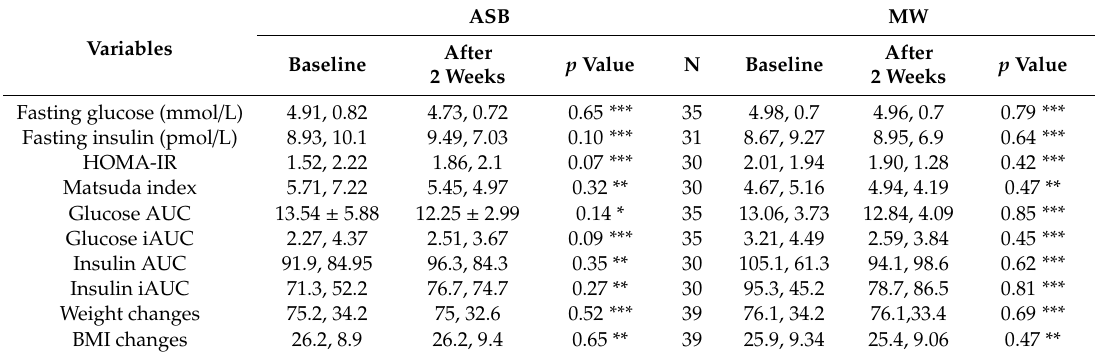
Table 2. E ff ects of artificial sweeteners aspartame and acesulfame K in within-group comparison.